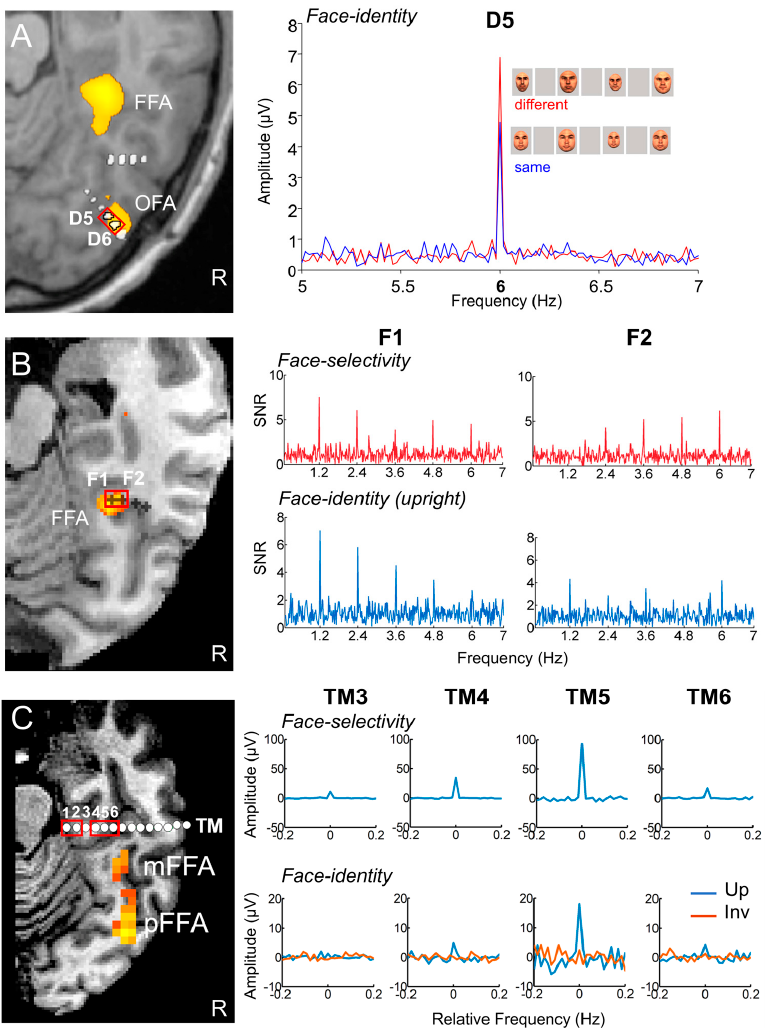
Figure 22. Direct electrical stimulation effects on FIR (transient prosopagnosia) are closely linked to local face-selectivity and sensitivity to face identity recorded on critical contacts. For all cases, the